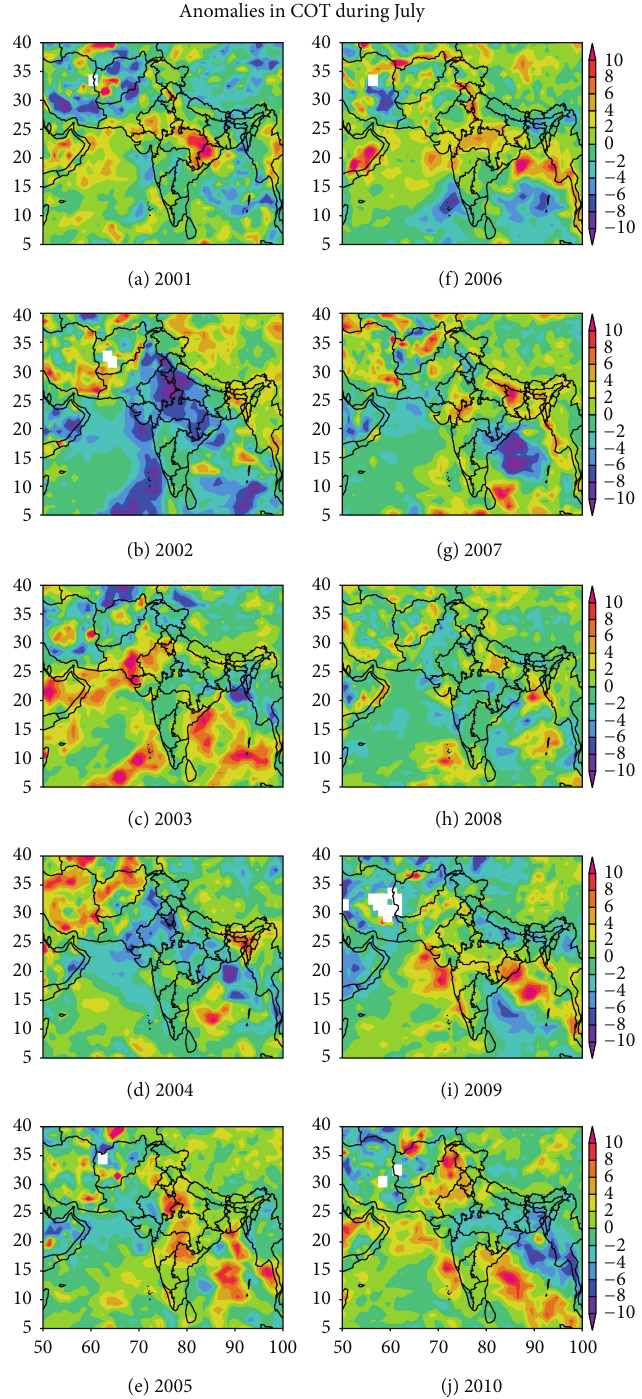
Figure 13: Anomalies in cloud optical thickness (COT) over the Arabian Sea, India, and the Bay of Bengal during July in (a) 2001, (b) 2002, (c) 2003, (d) 2004, (e) 2005, (f) 2006, (g) 2007, (h) 2008, (i) 2009, and (j) 2010.